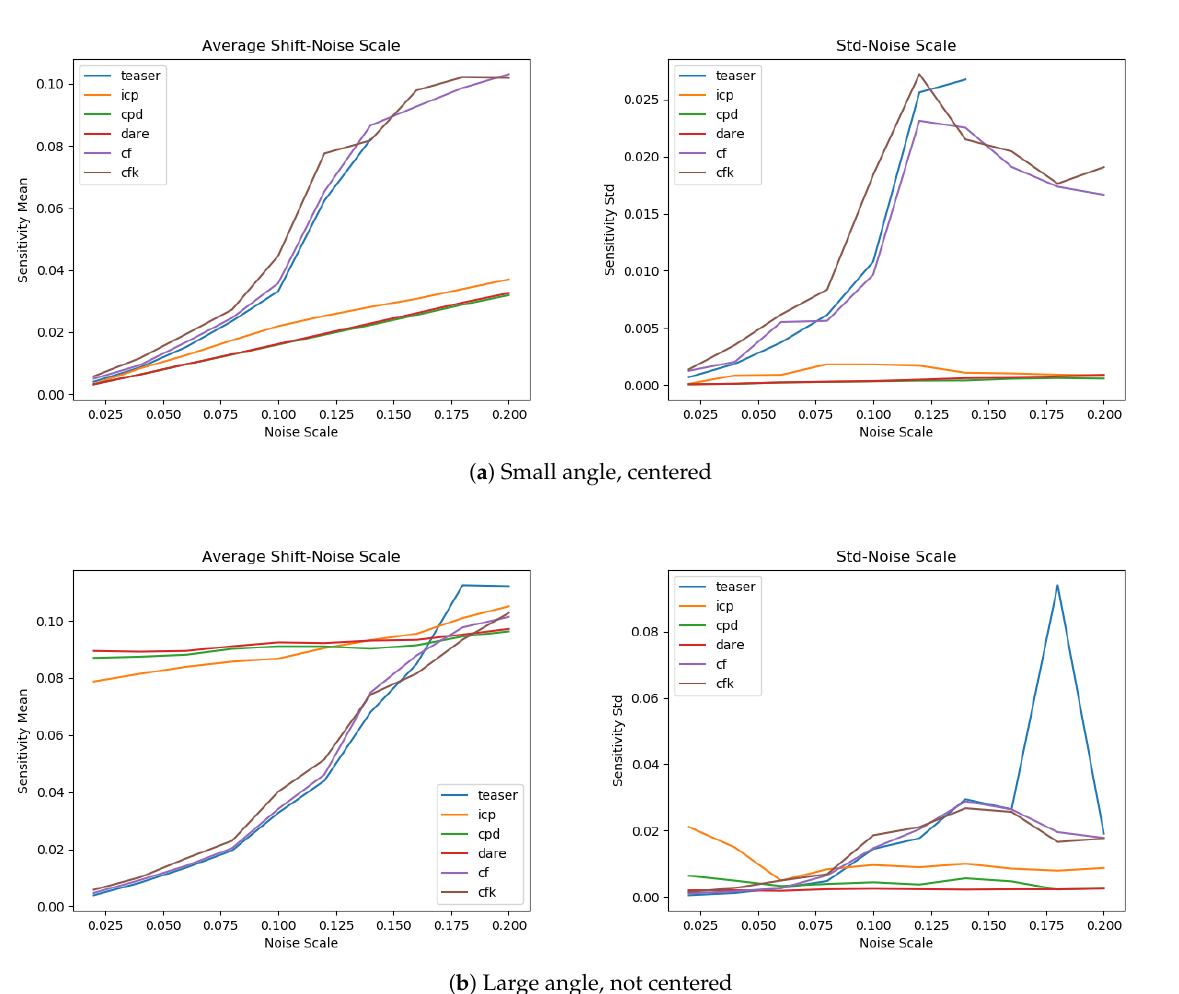
Figure A5. Sensitivity test. The left two plots show results with small rotation, centered. The right two plots show results with large rotation, not centered. The first and third diagrams show the mean shift to noise scale. The second and fourth diagrams show the standard